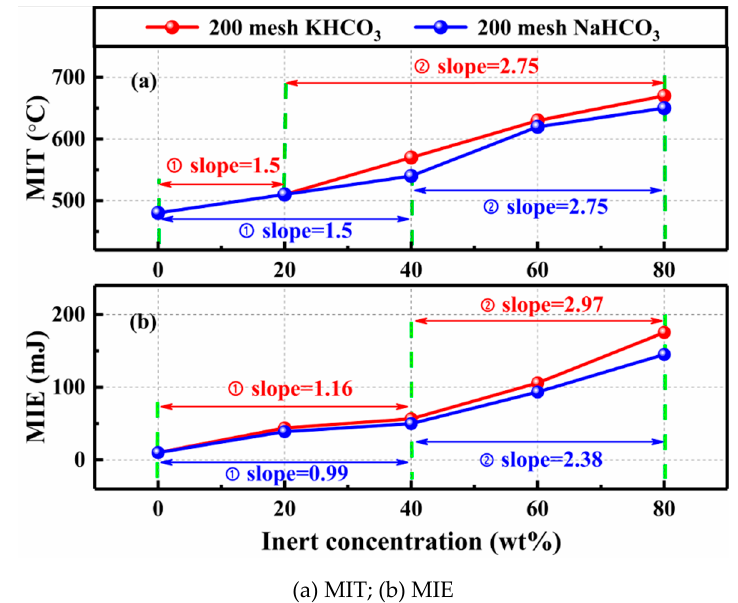
Figure 9. Effect of the NaHCO 3 and KHCO 3 powder concentrations on the MIT and MIE of PE. Figure 9. E ff ect of the NaHCO 3 and KHCO 3 powder concentrations on the MIT and MIE of PE.